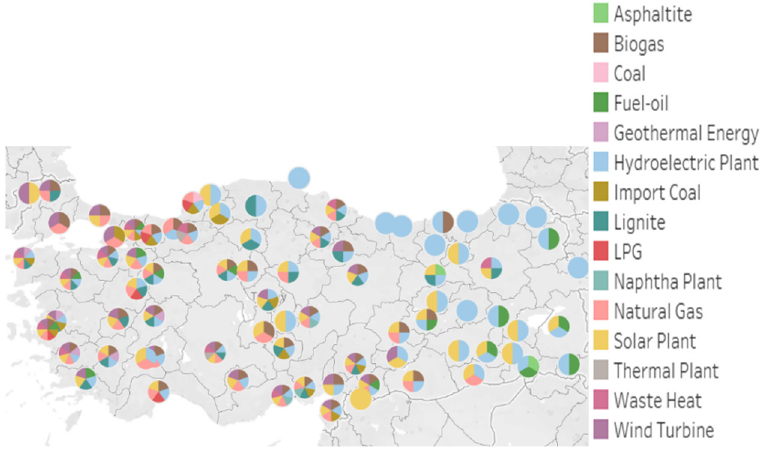
Figure 2. The generation facilities in Turkey by fuel type as adopted in the case study.